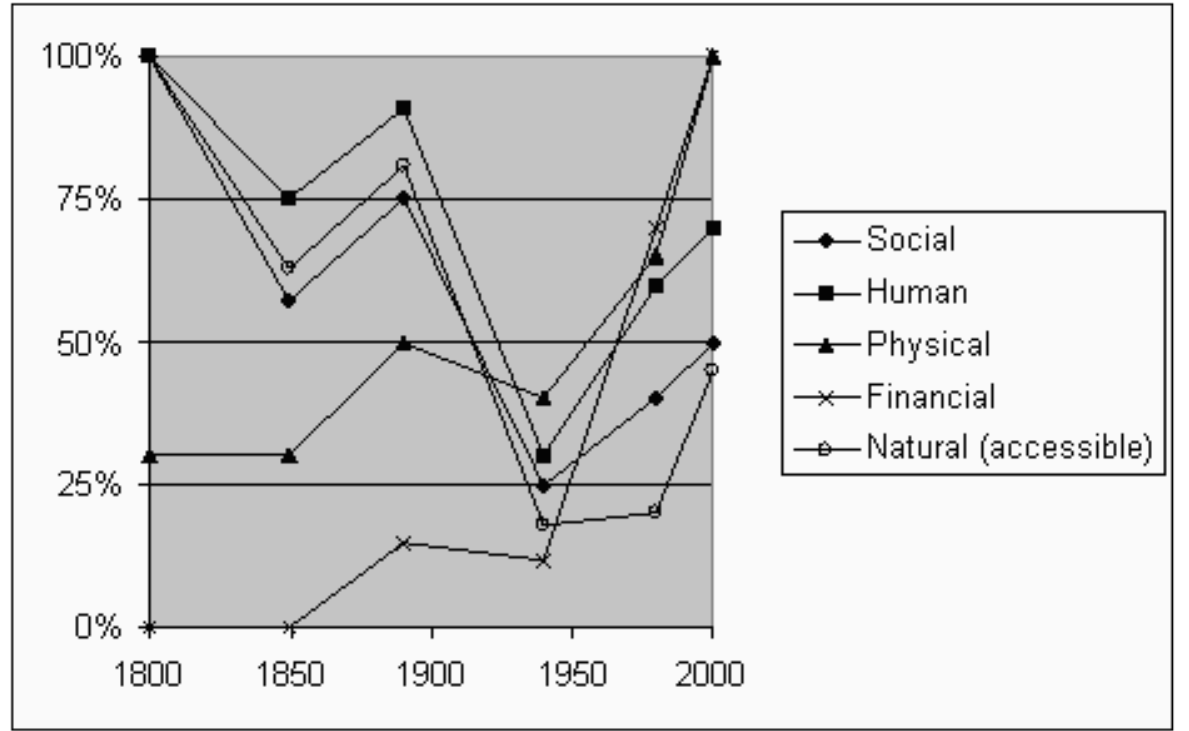
Fig. 4 . Postulated changes in levels of social, human, physical, financial, and natural capital during the history of the Aboriginal social-ecological system. The years before and after release ( W ) and reorganization ( a ) are shown. The first